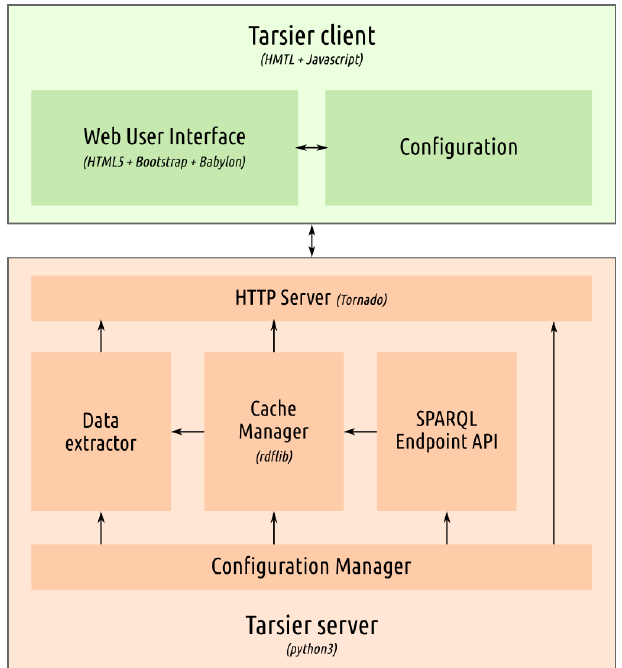
Figure 1. Software architecture of Tarsier. Implementation details are reported with the italic